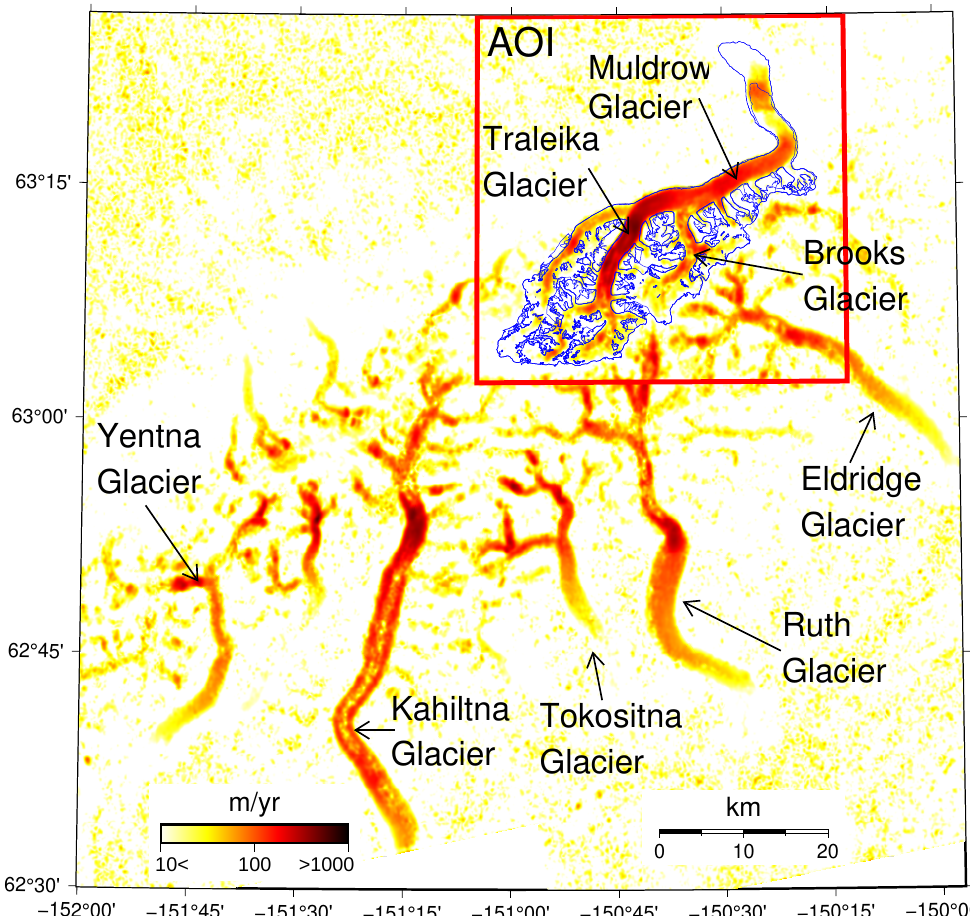
Figure 3. Magnitude of mean 4D flow velocities during 20141026–2021118, computed from Sentinel-1 ascending/descending range/azimuth offsets and plotted using logarithmic scale. Outline and names of glaciers are from Global Land Ice Measurements from Space database